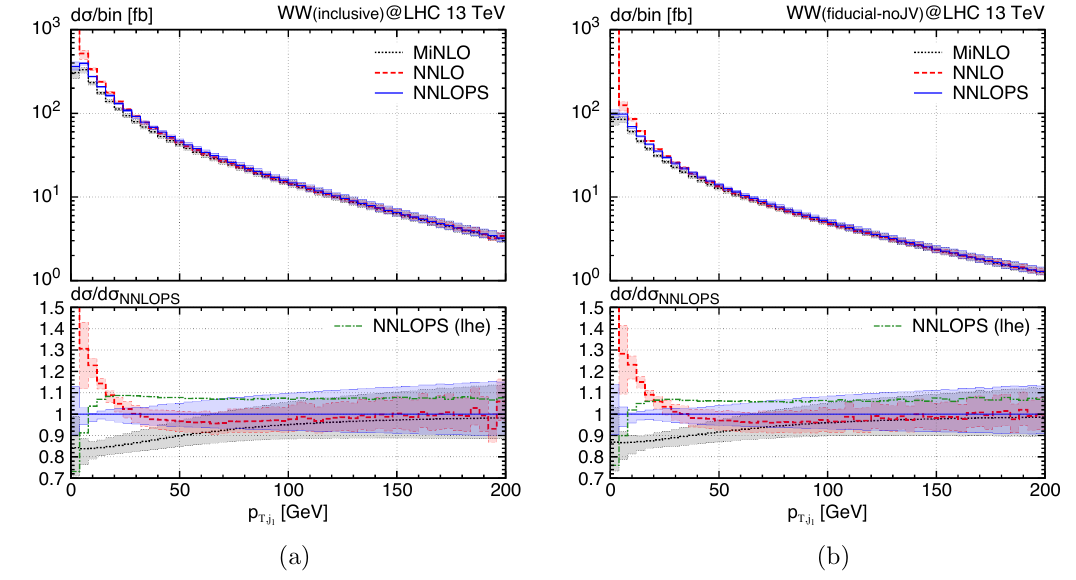
Figure 7 . Distribution of the cross section in transverse momentum of the leading jet as predicted by MiNLO (black, dotted), NNLO (red, dashed) and NNLOPS (blue, solid); for reference, central results of NNLOPS at LHE level (green, dash-dotted) are also shown in the ratio frame; (a) inclusive phase space and (b) fiducial-noJV